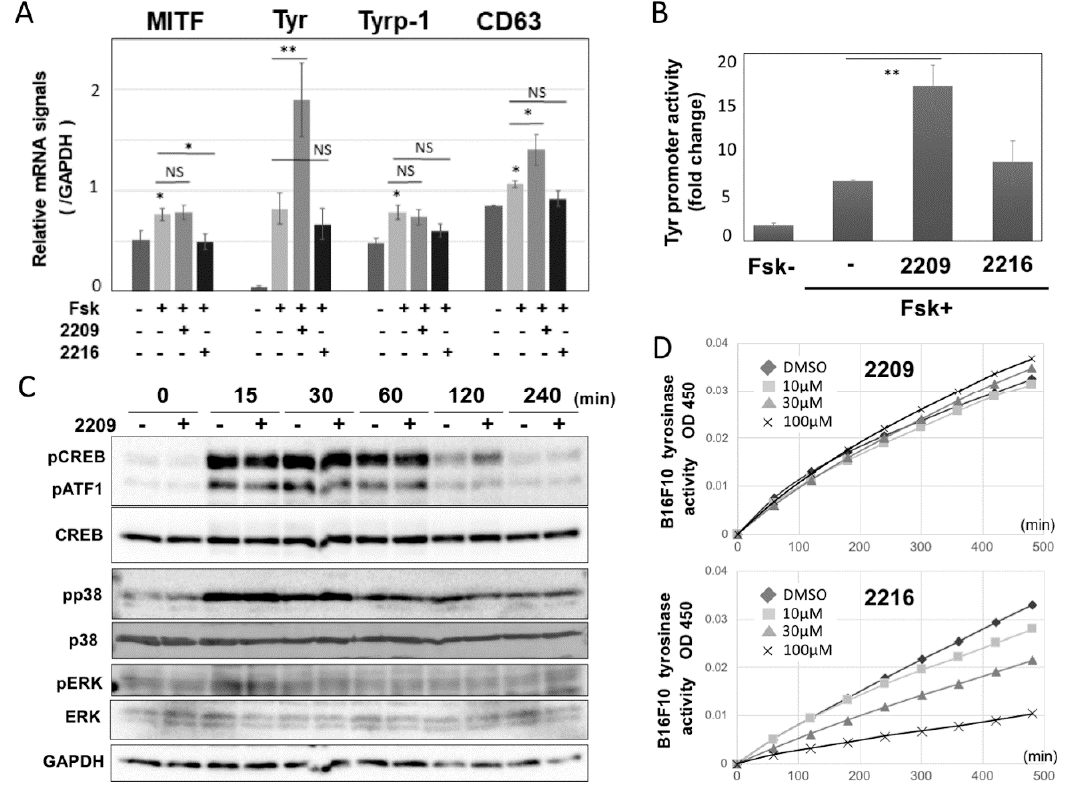
Figure 3. ( A ) B16F10 cells were treated with 10 μ M of GIF-2209 or GIF-2216 and 20 μ M Fsk for 24 h.